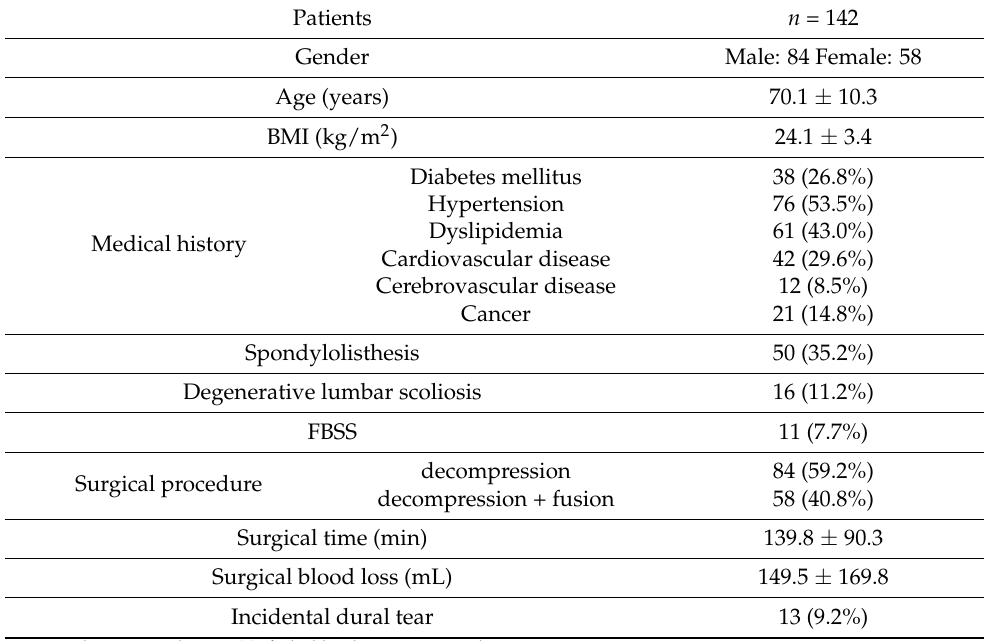
Table 1. Baseline characteristics of